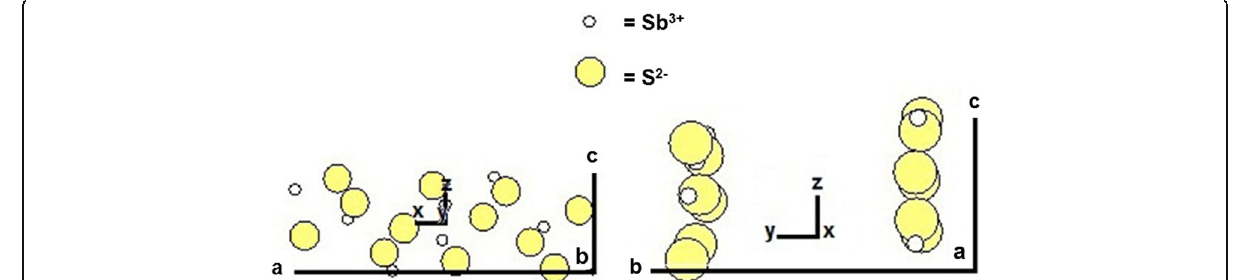
Fig. 6 The growth of Sb 2 S 3 obtained by computer modeling